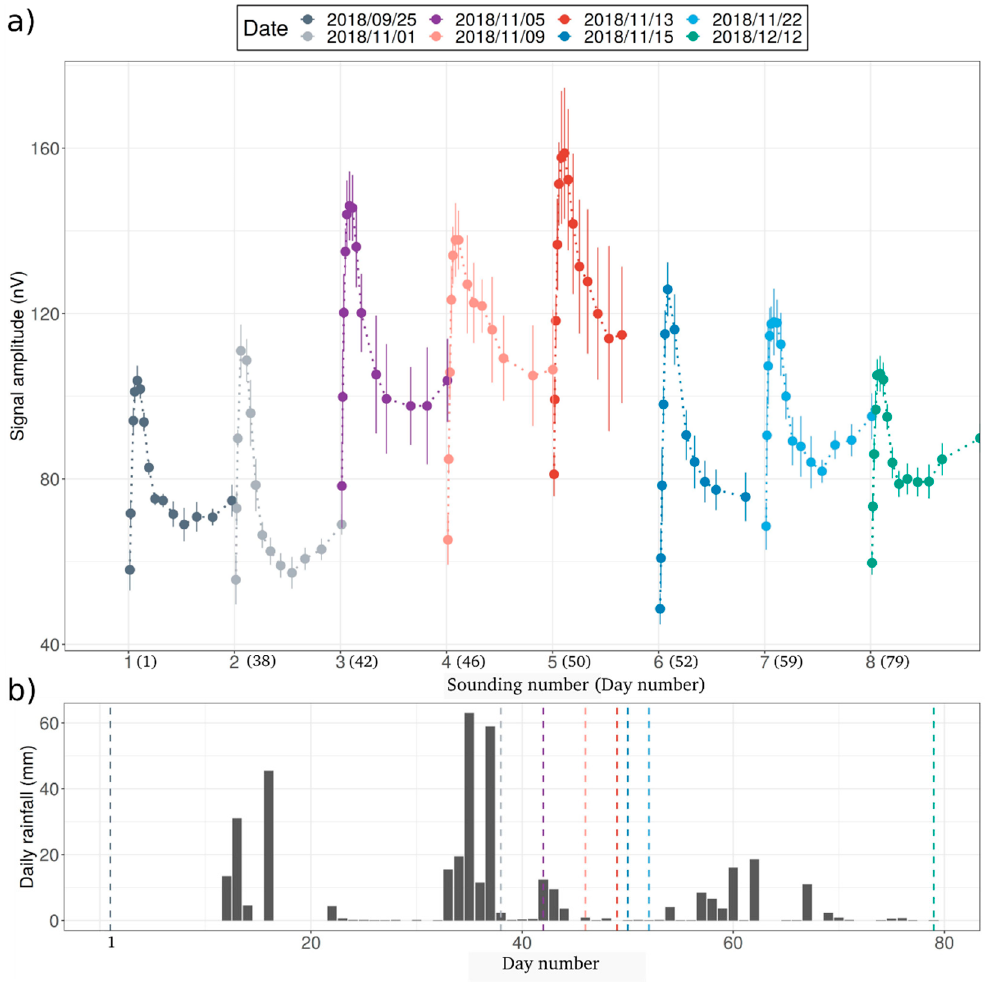
Figure 2. Temporal variability in the SNMR signal. ( a ) Signal amplitude as a function of the energizing pulse for all soundings. ( b ) Daily rainfall. Days are numbered since the 1st sounding was performed (the dotted vertical lines represent the 8 SNMR soundings).